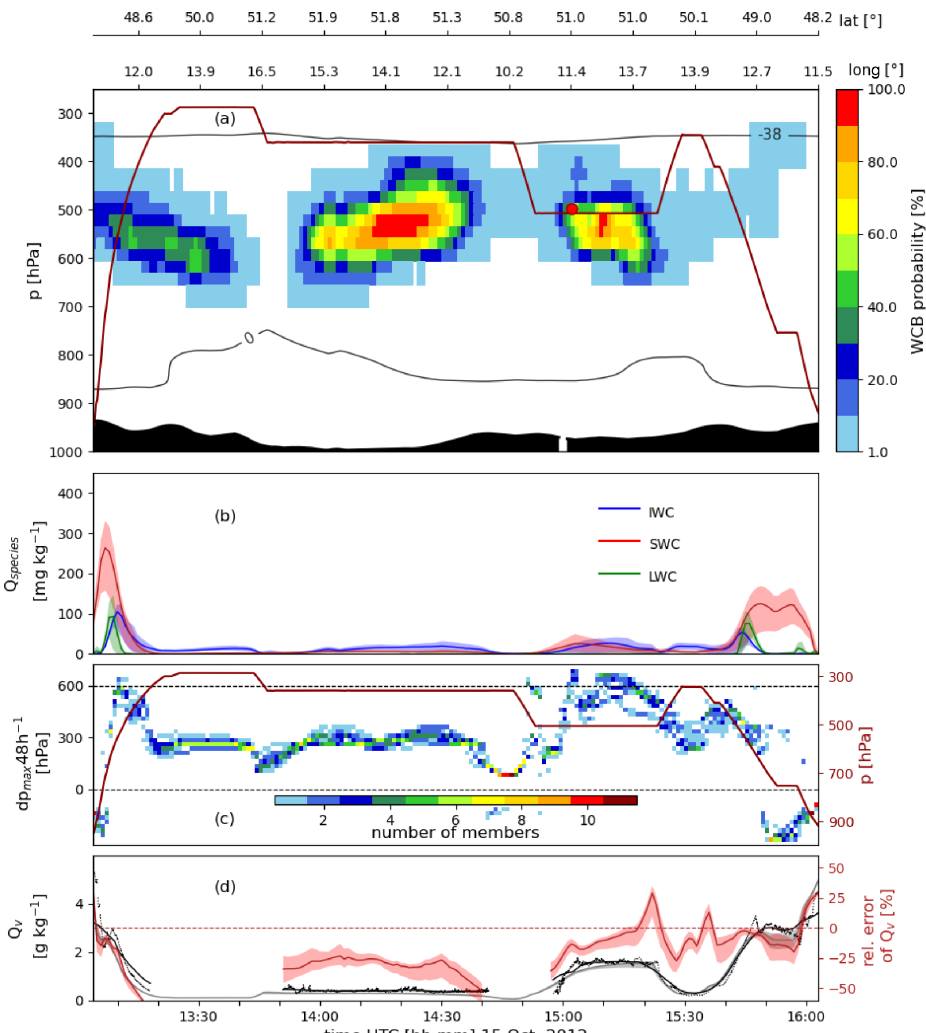
Figure 5. Same as Fig. 4 without panel (e) but for the Falcon flight